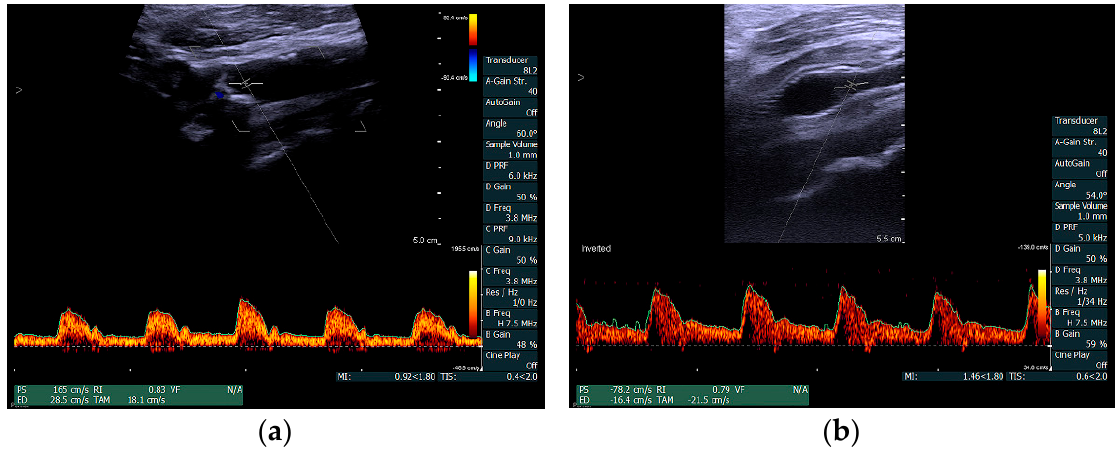
Figure 2. Duplex ultrasound (DUS) example of a carotid artery stenosis patient (no. 10) before and after stent treatment. Image ( a ) shows the DUS estimation of the stenotic site with peak-systolic velocity (PSV) of 165 cm / s and end-diastolic velocity (EDV) of 28.5 cm / s; Image ( b ) shows the DUS estimation after stent treatment.